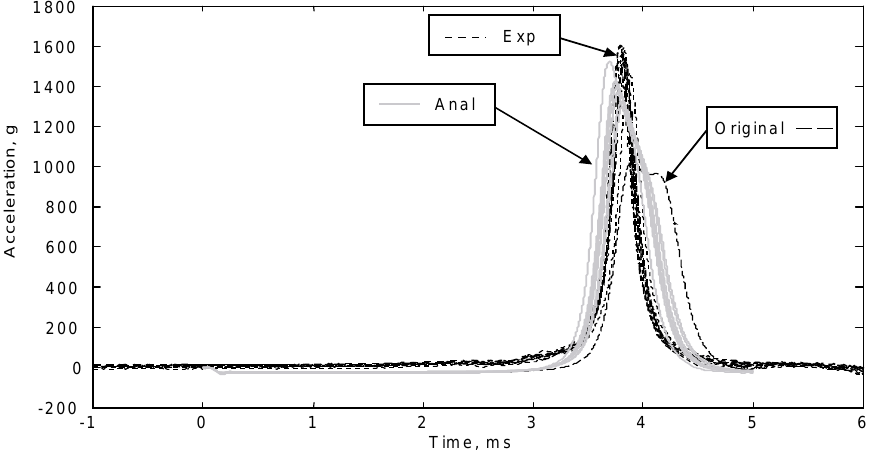
Fig. 14. Comparison between analytical and experimental response